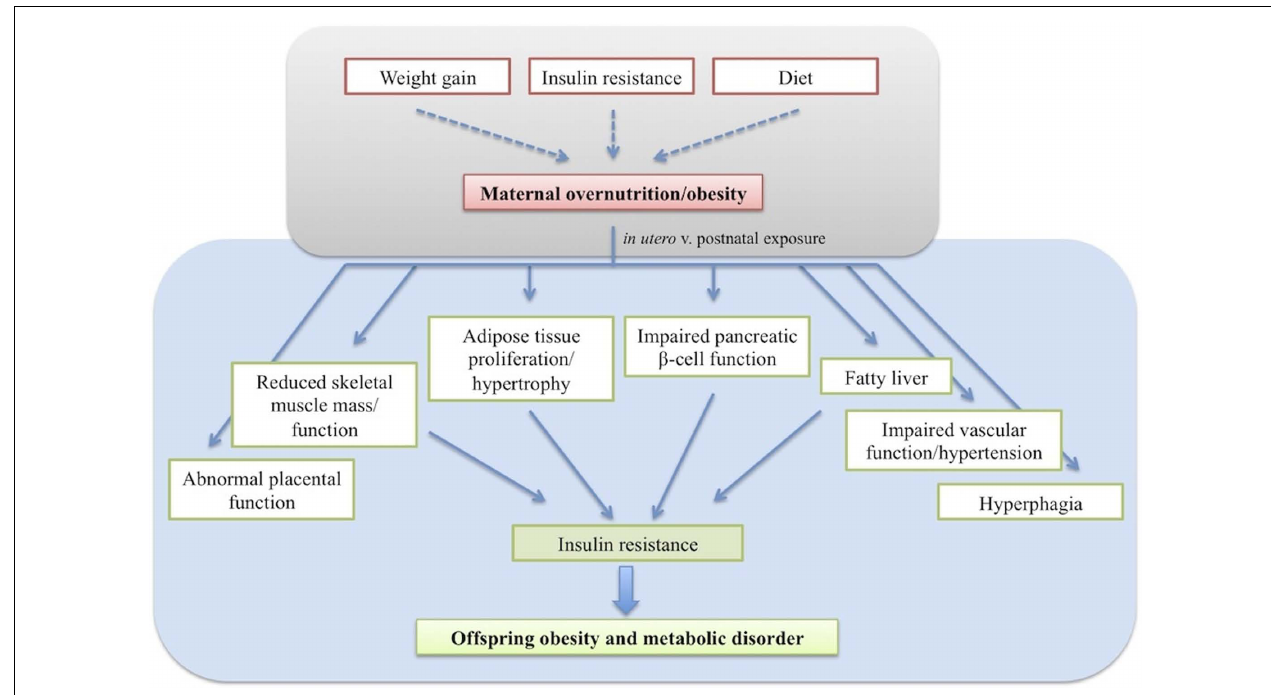
FIGURE 1 |The effects of developmental programming on offspring phenotype resulting in insulin resistance and